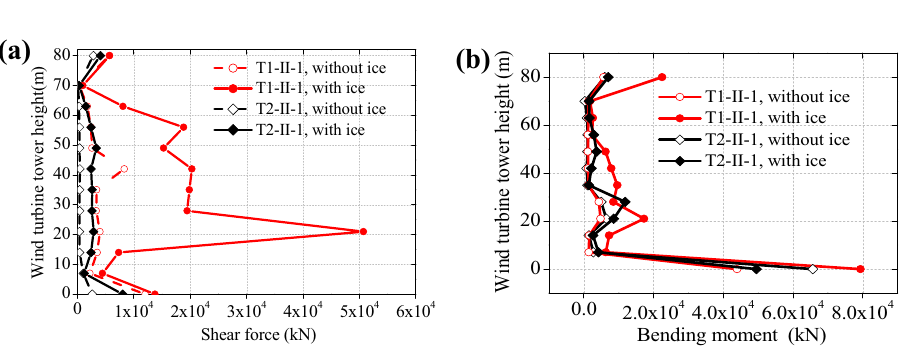
Figure 7. Influences of sea ice upon force in the structure: ( a ) shear force; ( b ) bending